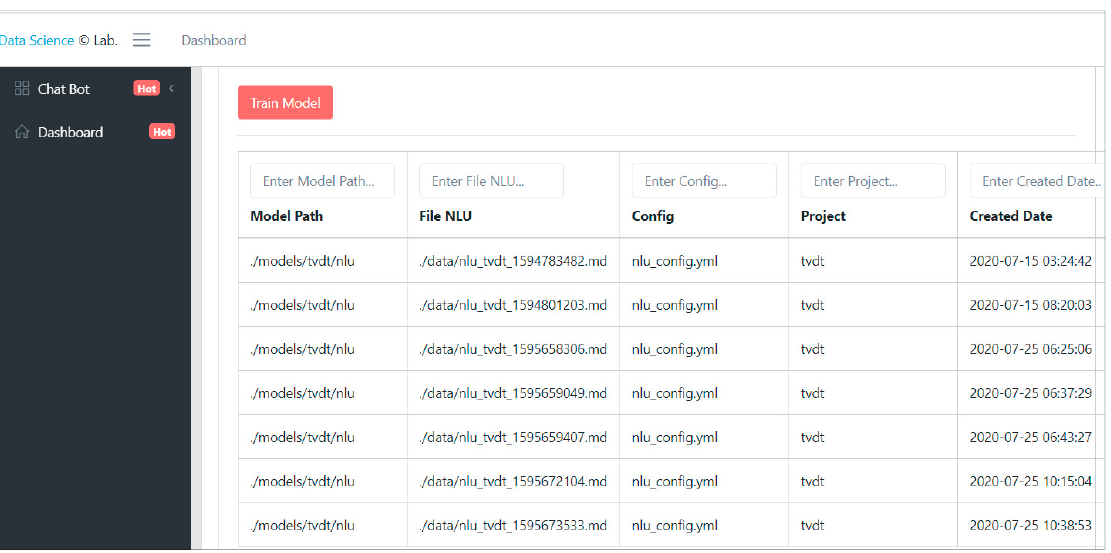
Figure 18. Training model and test function.